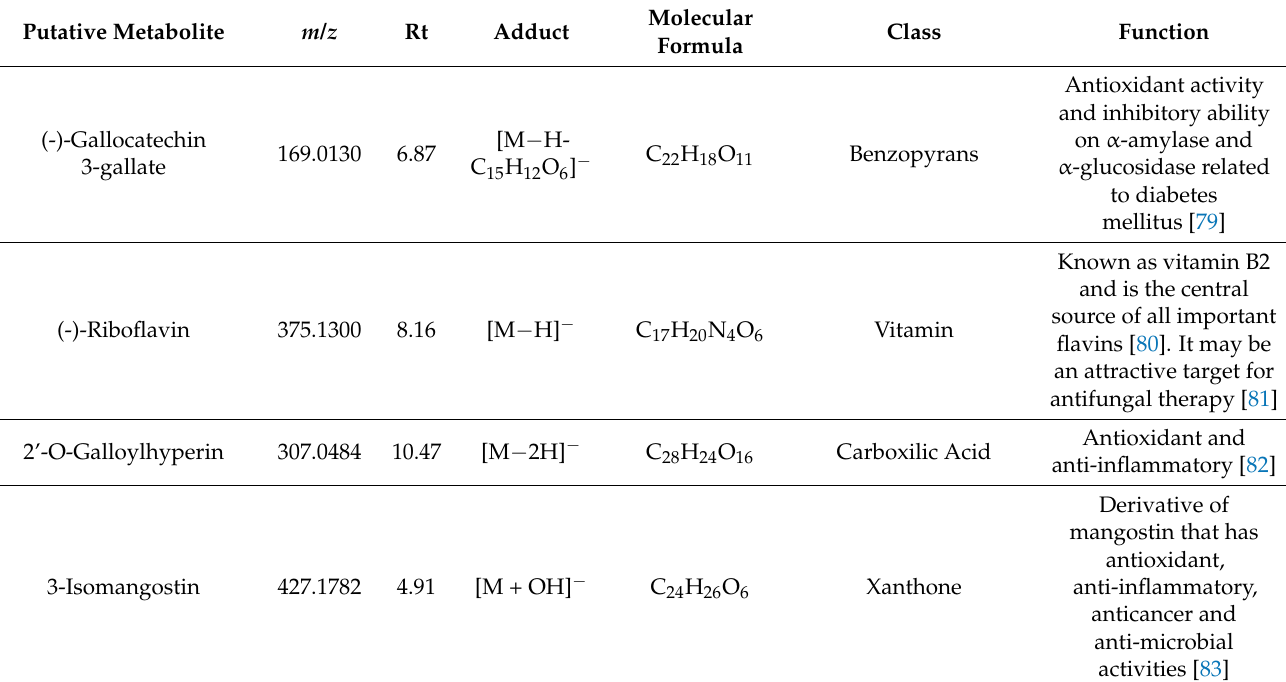
Table 5. Metabolites with biotechnological potential of Emericellopsis cladophorae MUM 19.33 belonging to various chemical classes and related functions. Metabolites were annotated at MSI-level 2. m / z — ration mass/charge; Rt—retention time